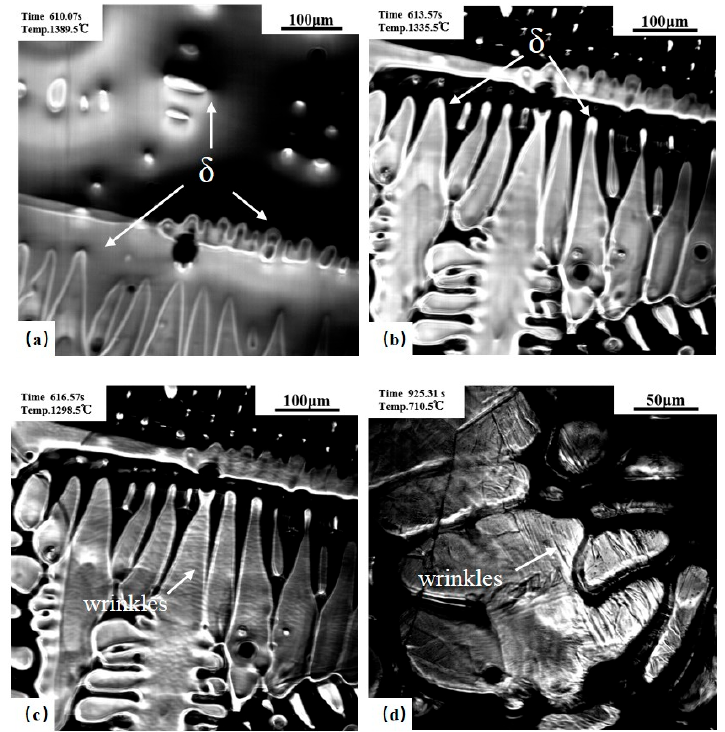
Figure 6. CSLM results of the 0.16C% steel. ( a ) δ growth; ( b , c ) before and after δ – γ transformation; ( d ) the wrinkles of low temperature phase transformation.